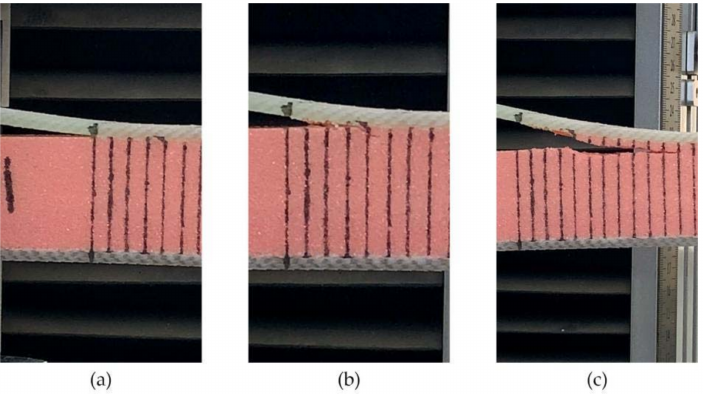
Figure 11. Crack propagation process in FH-0. ( a ) Crack initiation. ( b ) Pore-guided main crack bridging in the foam. ( c ) Smooth crack propagation in the